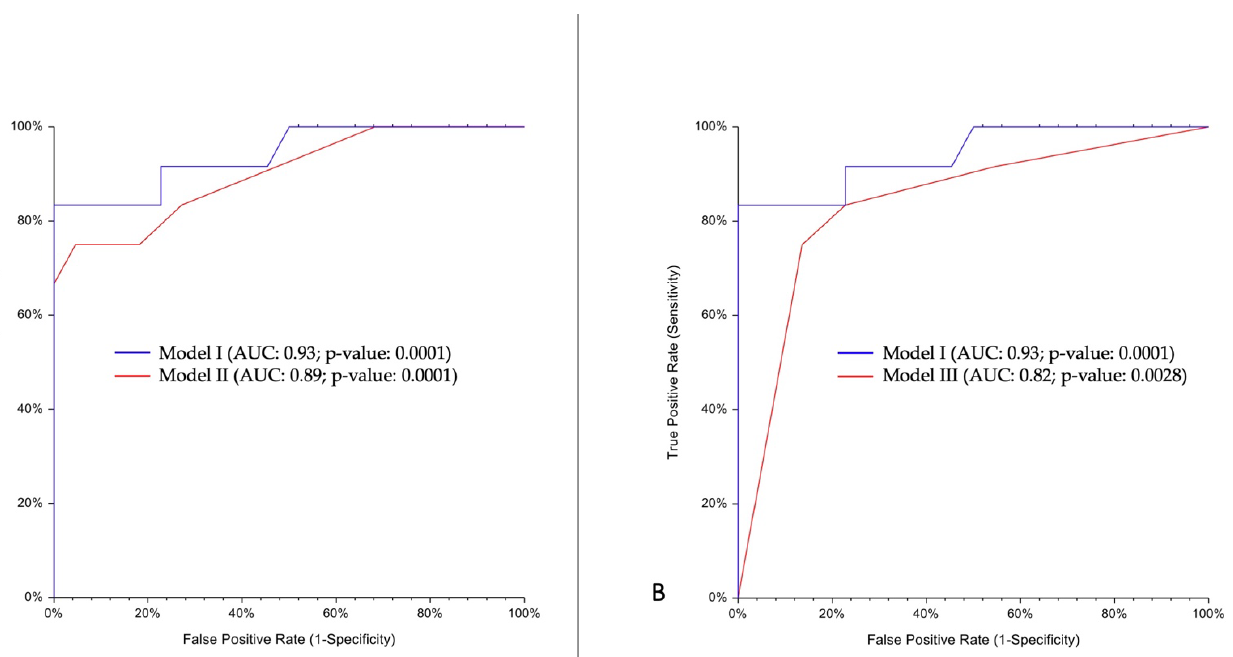
Table 2. Primary and Secondary Outcome According to Symptoms, Multivessel Disease, Ischemia of similar ischemic burden involved inferior segments from the base to the apex (black arrowheads). and Strain. In (g), a single systolic frame from HLA cine sequence with superimposed colorimetric map of GLS. On the right, the legend of colorimetric map with correlation between values and colors. In panel ( C ), the comparison between the different GLS. Despite a similar ischemic burden, the two patients report different GLS abnormalities (white thick arrows), suggesting a different impact of ischemia on global deformability. GLS acts as accurate index of early global impairment beyond the focal injury. spCMR: stress perfusion cardiac magnetic resonance; CCS: chronic coronary syndrome; SA: short-axis; LGE: late gadolinium enhancement; HLA: horizontal long-axis; GLS: global longitudinal strain.